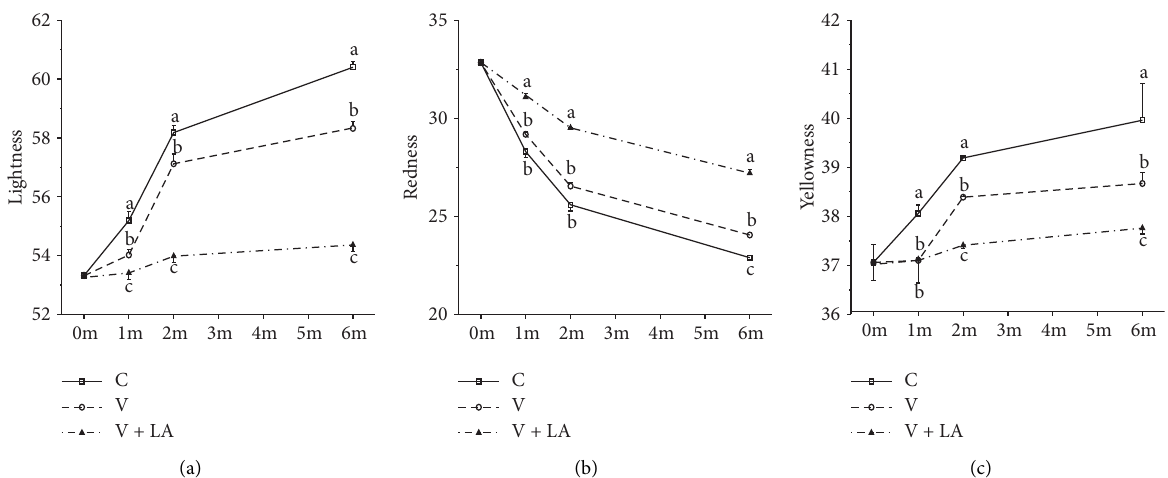
Figure 1: Efect of diferent packaging on lightness, (a) redness, (b) and yellowness (c) of the dried whole chilli during storage. C: Control with polyamide/polyethylene flm; V : vacuum packaging with polyamide/polyethylene flm; V +LA: vacuum and light-avoided packaging with aluminum polyethylene flm. a–c represent the signifcant diference ( P < 0 . 05) of dried pepper stored in diferent packaging.